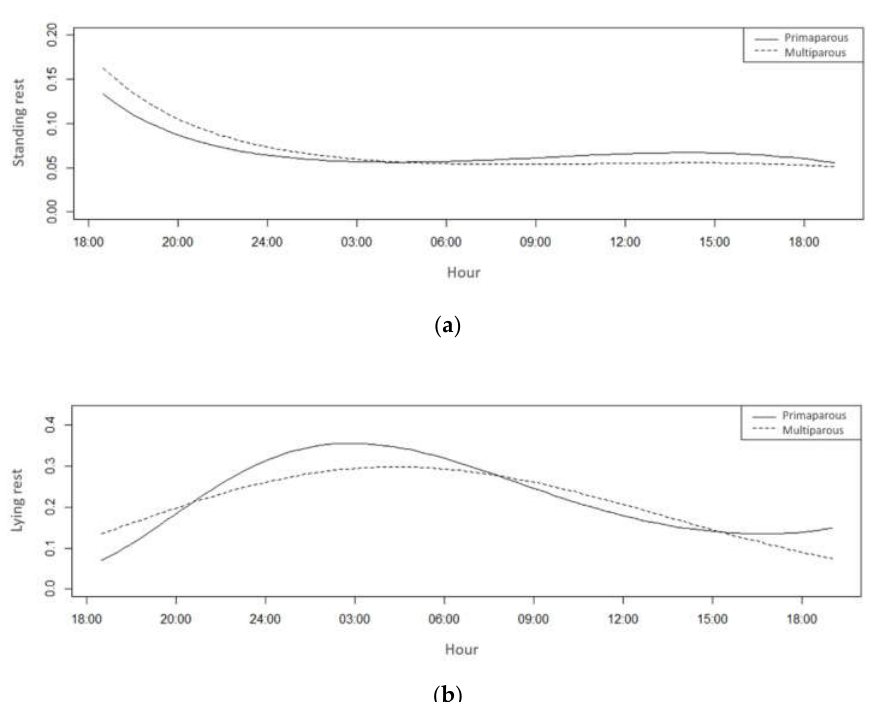
Figure 11. Standing rest ( a ) and lying rest ( b ) probability of primiparous (solid line) and multiparous cows (dotted line) in a compost barn.